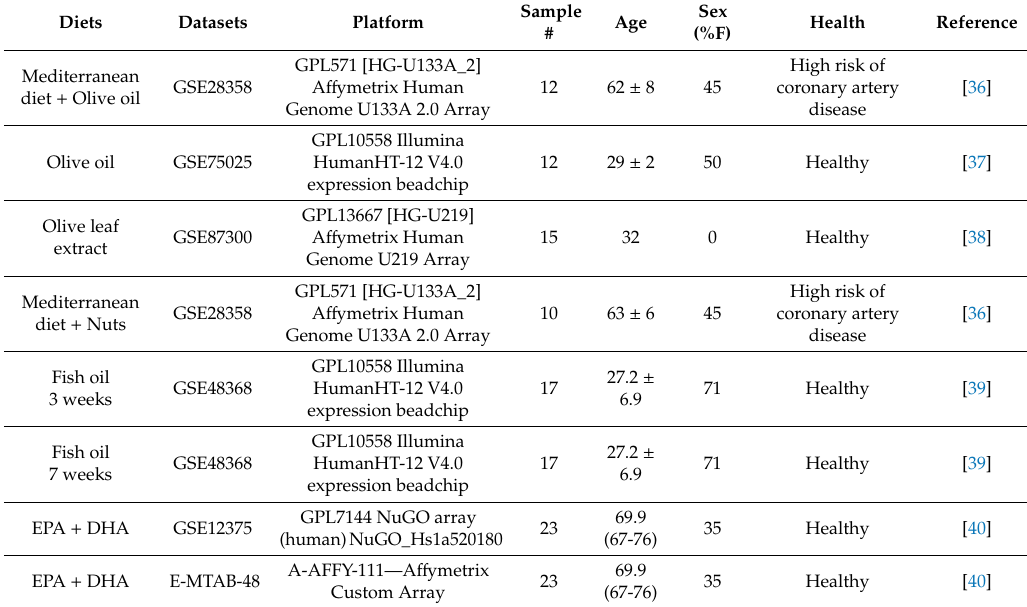
Table 1. Gene expression datasets used in this study. The peripheral blood mononuclear cells (PBMC) transcriptomic studies that were selected for analysis are presented in the table. Age is indicated in years as mean ± SD, or mean alone, or mean (range) depending of the information available. EPA + DHA: eicosapentaenoic acid and docosahexaenoic